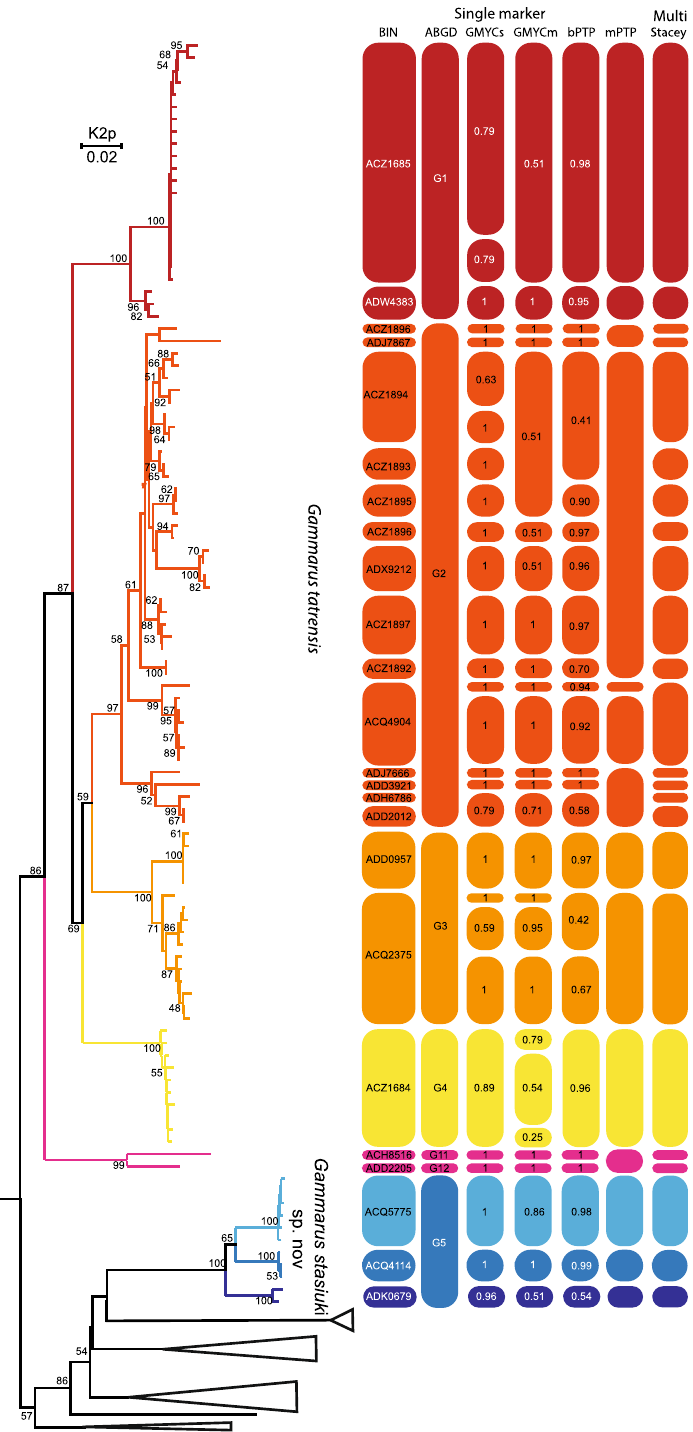
Figure 1. MOTUs delimitation. Neighbour-Joining tree constructed using COI haplotypes and Kimura 2-parameter distance. Bootstrap values > 50 annotated. Bars represent results of species delimitation methods. Outgroups